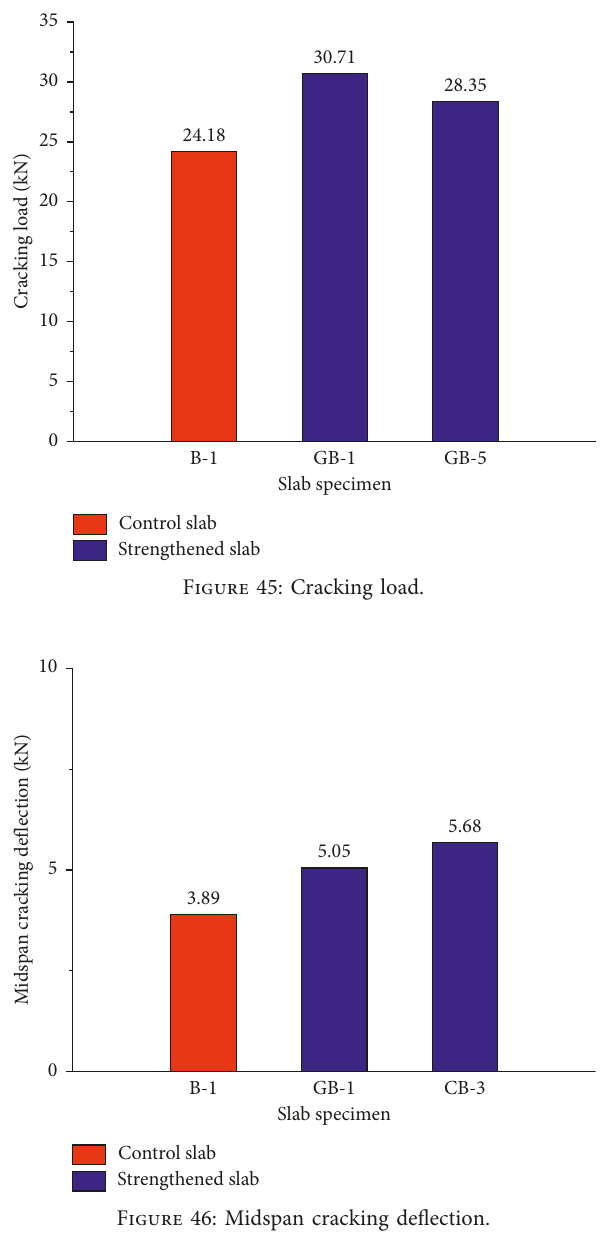
Figure 46: Midspan cracking deflection.